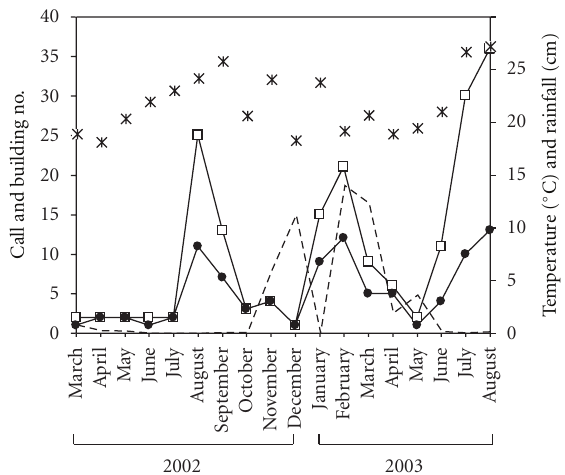
Figure 2: Month to month record of infestations and climate data at UCLA. Lines with open squares are the number of total calls; lines with closed circles are the number of buildings infested. The crosses are the mean maximum temperature for the month, and the dashed line is the cumulative monthly rainfall (both from the UCLA station of the National Environmental Satellite, Data, and Information